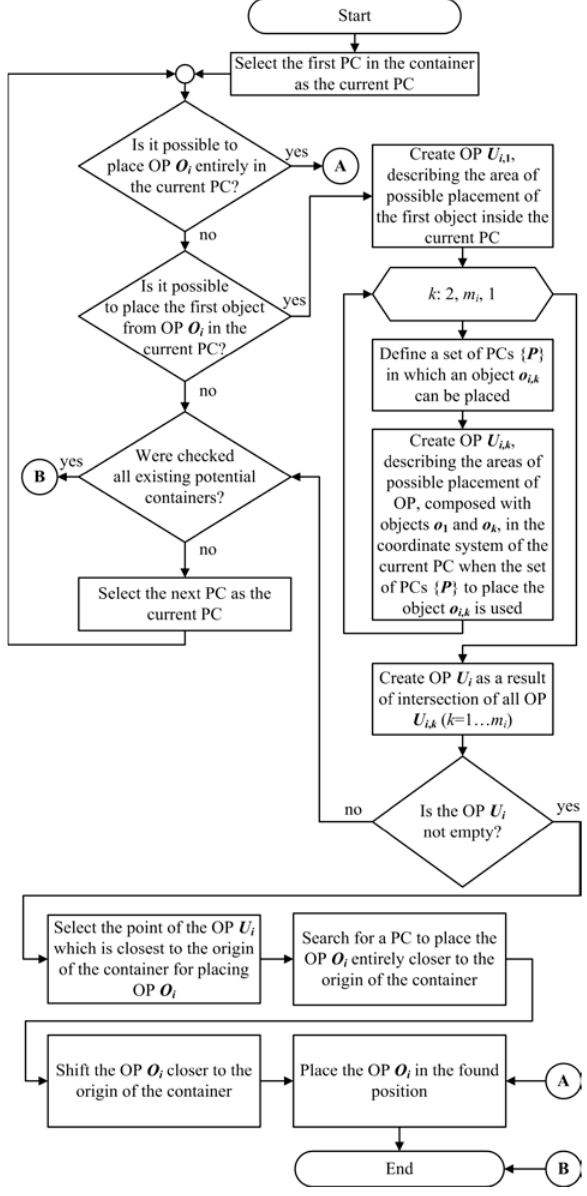
Fig. 7. Algorithm for placing an orthogonal polyhedron .